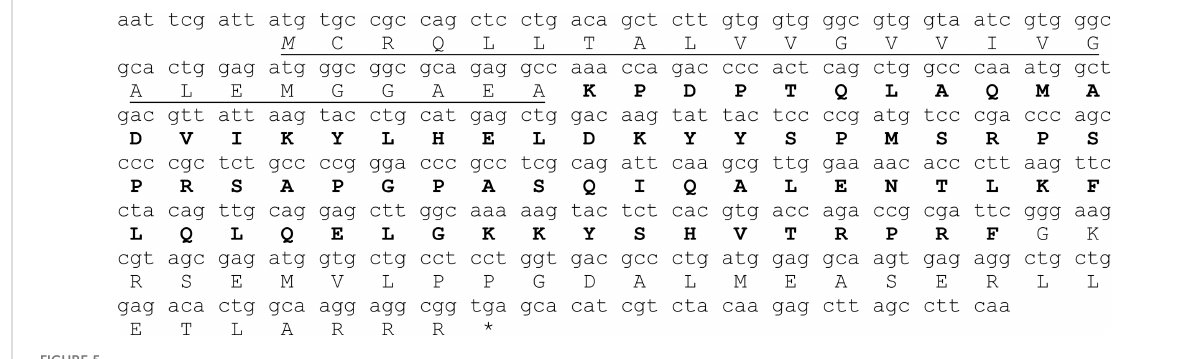
FIGURE 5 Nucleotides corresponding with the deduced amino acid sequence of the full-length S. olivacea neuropeptide F II ( Scyol-NPF II ) are shown; within 414 nucleotides of Scyol -VIH cDNA sequence, and 375 were predicted to be an open reading frame. The open reading frame was translated into 124 deduced amino acids; small and capital letters indicate nucleotide and amino acid sequences, respectively. A black italic M letter represents a start codon, while an asterisk a stop codon. Signal peptide sequence of Scyol -NPF II is indicated by underlined italic letters. Black bold letter indicates the active form of NPF-II.